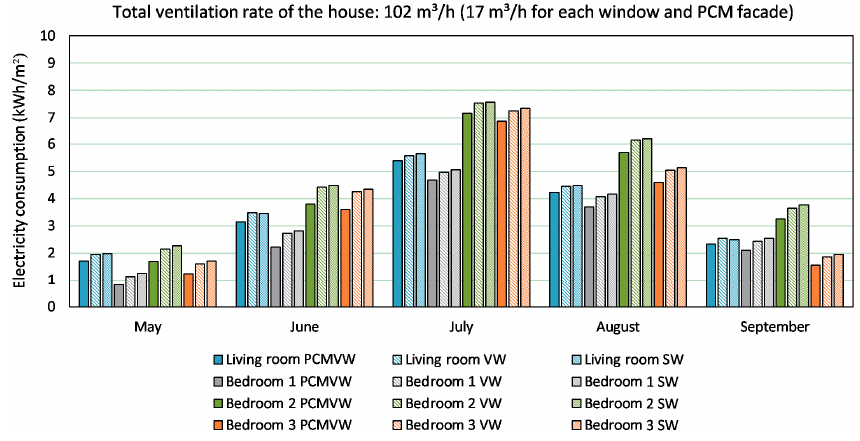
Figure 12. The heat pump electricity consumption of each room during the summer period at a ventilation airflow rate of 102 m 3 /h.